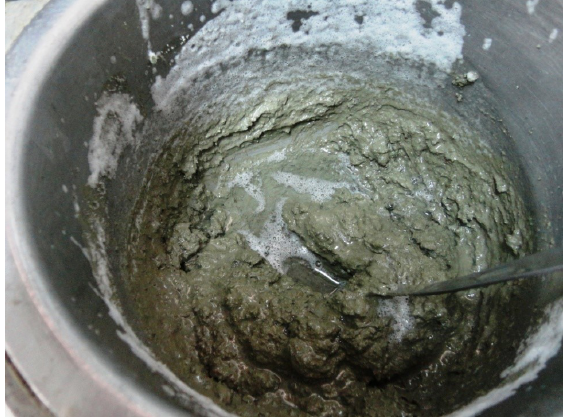
Figure 5. Liquid paraffin on the surface of a PX27 mortar